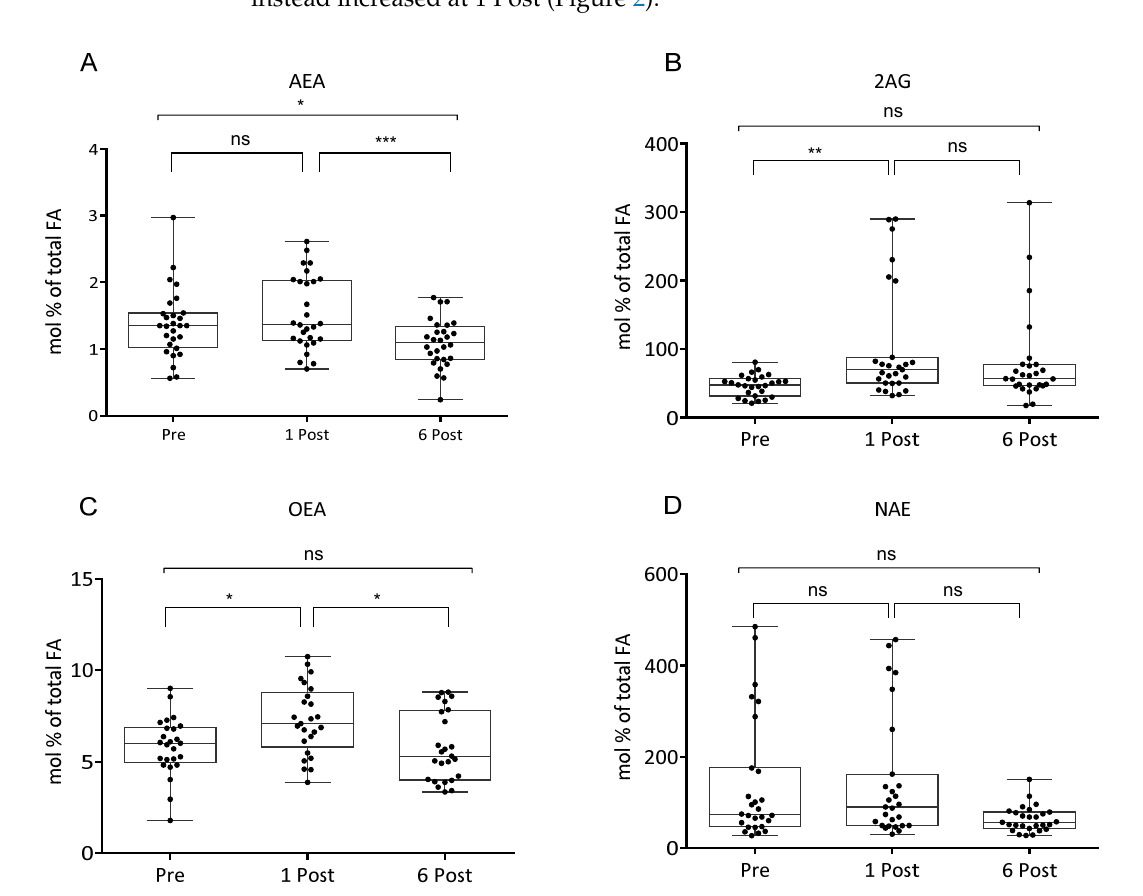
Figure 2. Values of N -arachidonoylethanolamine (AEA, ( A )), 2-arachidonoylglycerol (2-AG, ( B )), N -oleoylethanolamine (OEA, ( C )), N-acylethanolamine (NAE, ( D )), expressed as mol % of total fatty acid (FA), in subjects at baseline (Pre), one month (1 Post) and six months (6 Post) after bariatric surgery. Values are presented as boxes (mean value) and whiskers (higher and lower values) (AEA n = 28; 2AG n = 27; OEA n = 27; NAE n = 27). * p < 0.05; ** p < 0.01; *** p <